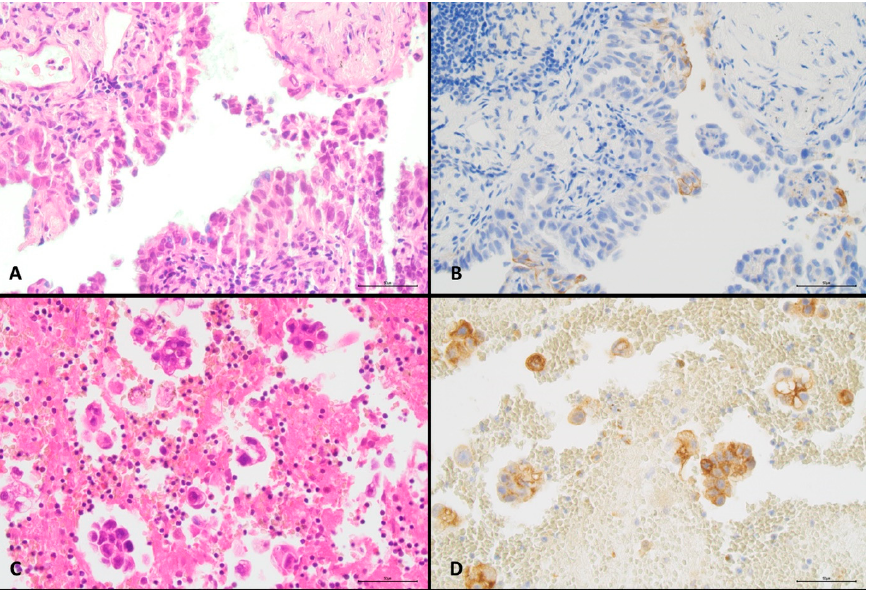
Figure 2. Discordant PD-L1 reactivity in paired histological and cytological specimens from a lung adenocarcinoma (original magnification ×400). ( A ) Transthoracic core biopsy, H&E staining, >500–1000 cells. ( B ) Transthoracic core biopsy, PD-L1 immunostaining, ≥ 5% positive malignant cells. ( C ) Pleural effusion, H&E staining, 100–300 cells. ( D ) Pleural effusion, PD-L1 immunostaining, ≥ 50% positive malignant cells.